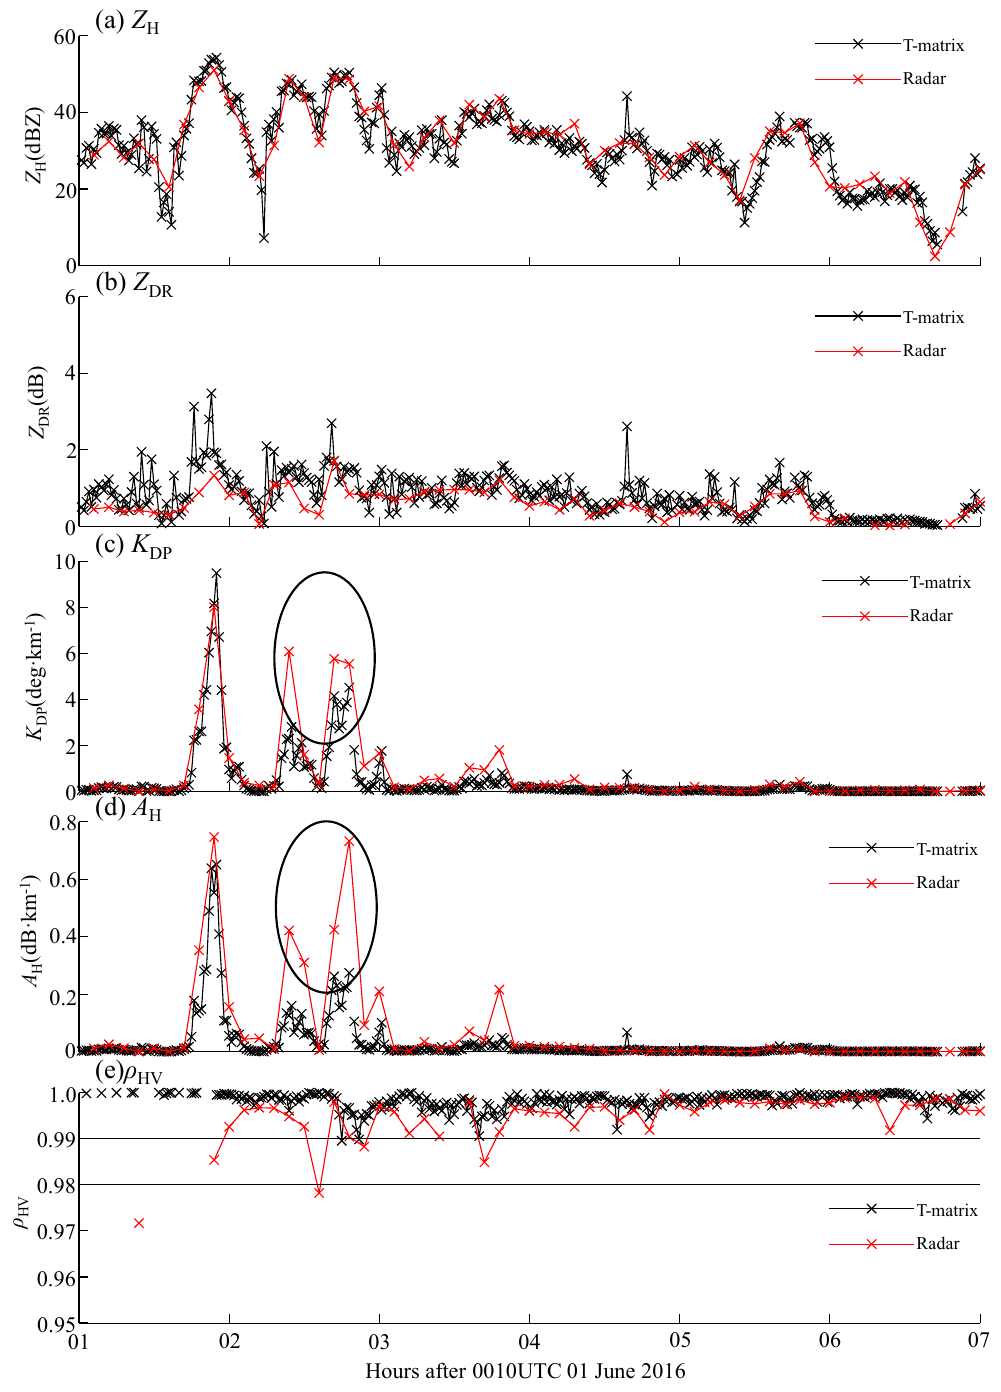
Figure 11. T-matrix-derived radar variables and CPOL radar measurements at CA station at 0100–0700 UTC on 1 June 2016: ( a ) Z H , ( b ) Z DR , ( c ) K DP , ( d ) A H , and ( e ) ρ HV . The ellipses on (c) and (d) indicate that the radar-observed K DP and A H values are larger than the T-matrix-simulated ones.